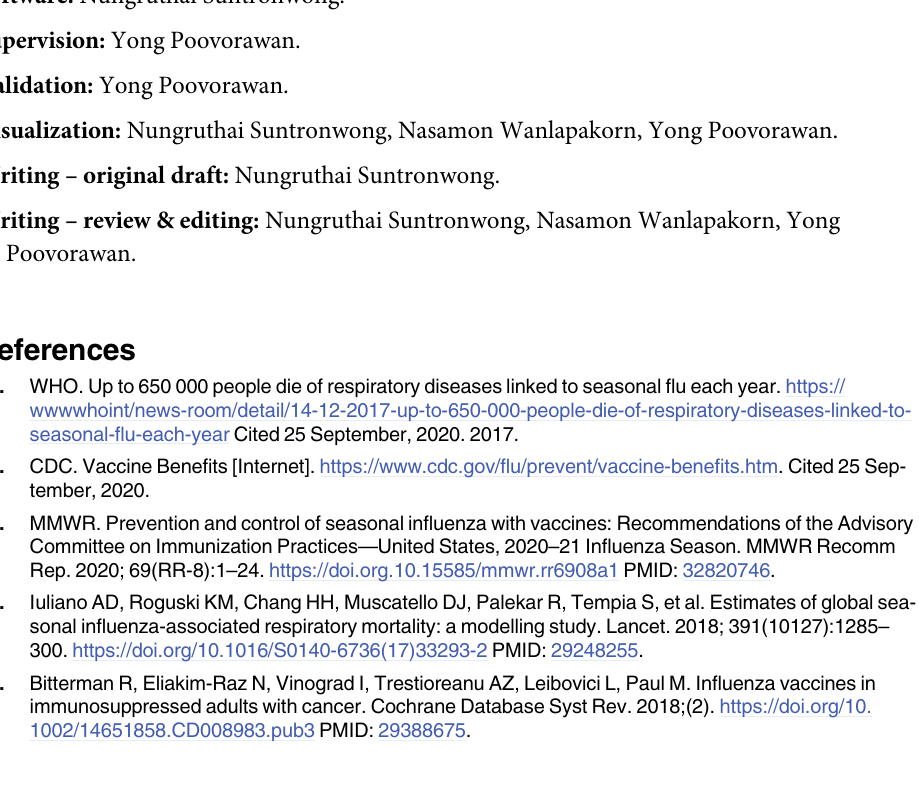
S4 Table. Comparison the seropositive rates (HAI titers � 1:40) against seasonal influenza viruses by gender, age groups and individuals with or without chronic